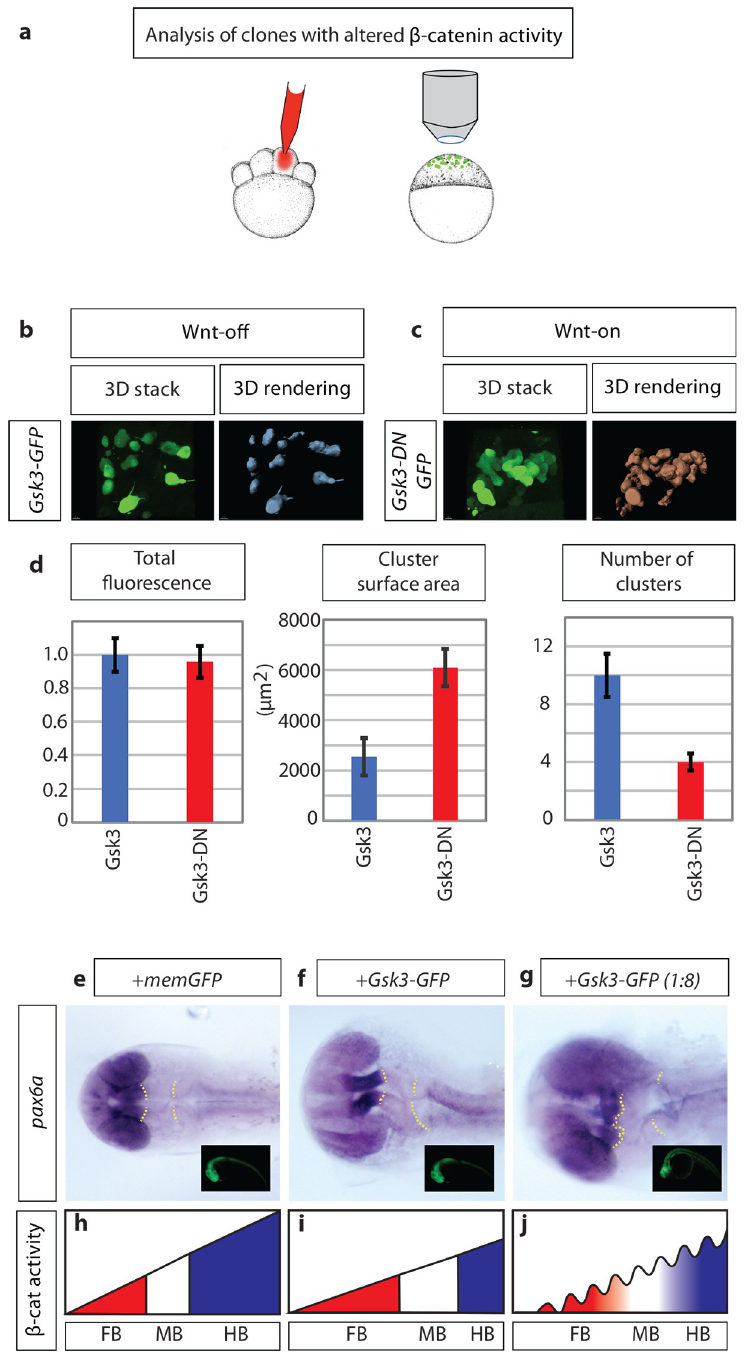
Fig 2. Wnt/ β -catenin positive clones display increased adhesiveness and disrupt patterning. a) schematic illustration of the experimental procedure: 150ng mRNA injection of β -catenin effector Gsk3 β into one cell at the eight blastomere stage. At sphere stage (prior induction of Wnt ligand expression), embryos were subjected to an image- based approach to analyse the distribution of cell clones in the animal tissue. b) expression of Gsk3 β -GFP (Wnt-OFF) leads to a dispersed clone at the sphere stage. c) However, expression of dominant-negative Gsk3 β -GFP (Gsk3 β - DN-GFP; Wnt-ON) leads to clustering of the clonal cells. d) Gsk3 β -DN expressing cells (Wnt-ON) show large clusters: demonstrated by an increased cluster surface and a reduced number of total clusters/cells compare to cells expressing WT Gsk3 β (Wnt-OFF). The expression levels of Gsk3 β and Gsk3 β -DN are kept at a similar level shown by comparable total GFP-fluorescence in the clones. e)-g), embryos were injected with the indicated constructs and subjected to in